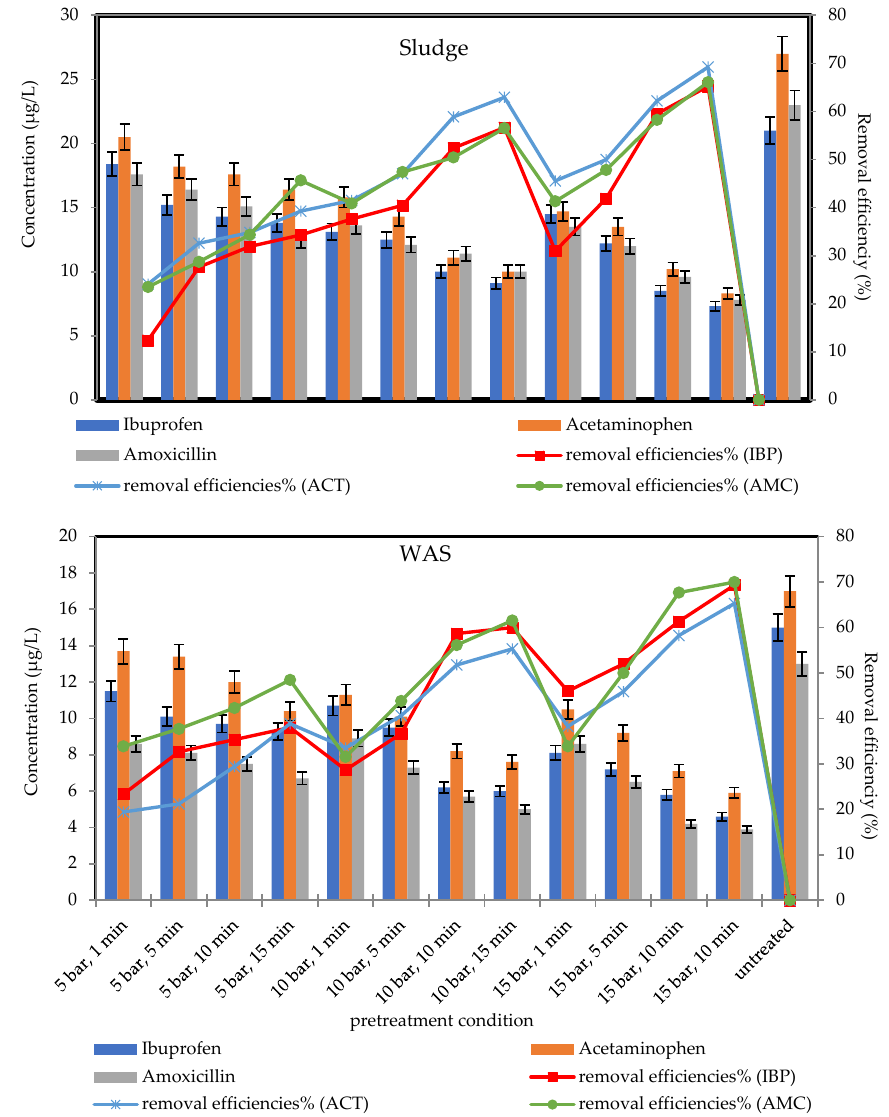
Figure 2. The efficiency of the steam explosion pretreatment in pharmaceutical reduction. Only pretreatment with a high pressure and long retention time (10 bar for 10 min, 10 bar for 15 min, 15 bar for 10 min, and 15 bar for 15 min) resulted in the degradation of the pharmaceuticals. The highest removal efficiencies for ibuprofen, acetaminophen, and amoxicillin were obtained in the primary sludge at percentage removals of 65%, 69%, and 66% respectively. For WAS, the removal rates were 70%, 66%, and 70% for ibuprofen, acetaminophen, and amoxicillin, respectively. Therefore, pharmaceutical residuals in primary sludge and WAS can be eliminated with a high pressure and long retention time with steam explosion pretreatment [31].